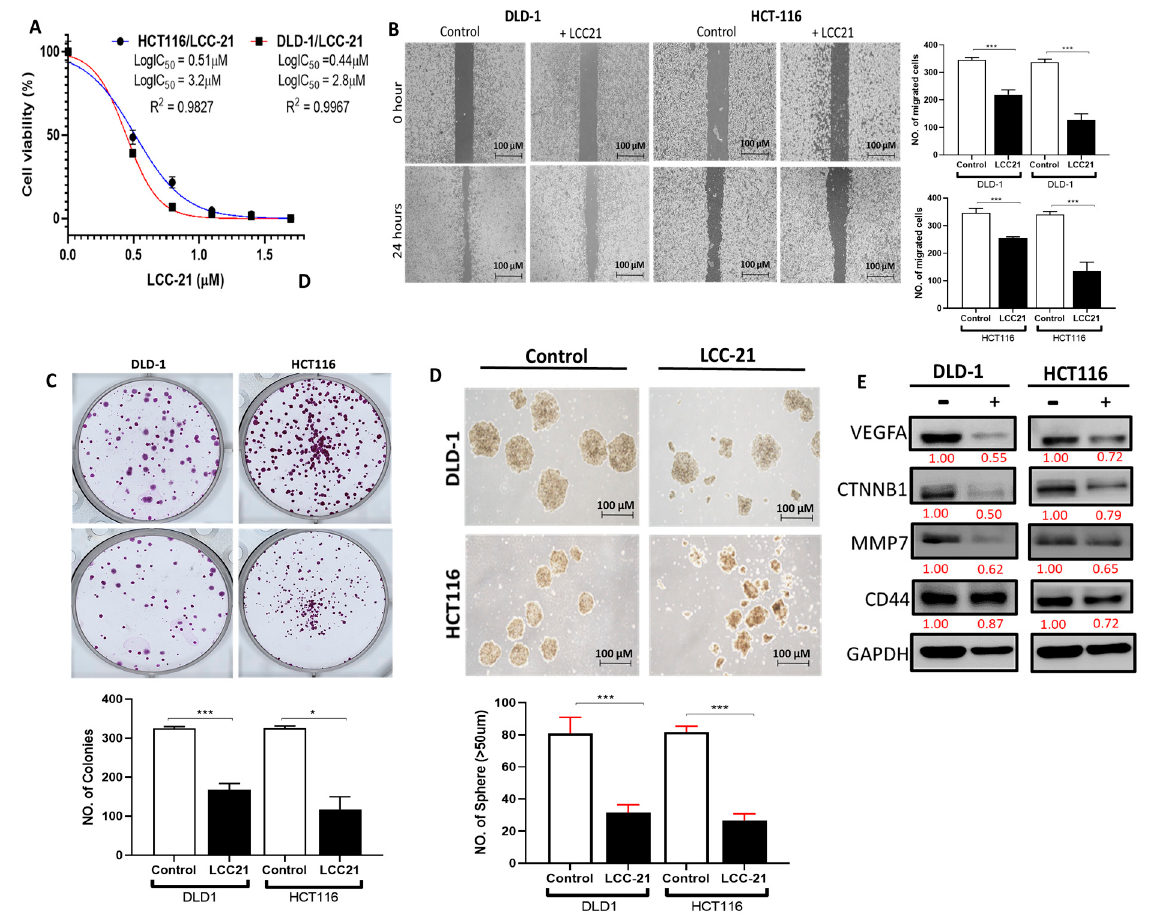
Figure 14. LCC ‐ 21 treatment suppressed the viability of colorectal cancer (CRC). ( A ) A cell viability assay demonstrated that LCC ‐ 21 effectively decreased the cell viability of CRC cell lines in dose ‐ dependent and time ‐ dependent manners. The experiments were performed three times, each with three replicates at each concentration The 50% inhibitory concentration (IC 50 ) values in the two cell lines (HCT116 and DLD ‐ 1) are indicated. ( B – D ) LCC ‐ 21 inhibited migration, colony, and sphere formation by DLD ‐ 1 and HCT116 cells. Images of the colony and spheroids are shown in the left upper panel, with quantification of the results in the right panel. ( E ) Western blot analysis shows that the LCC ‐ 21 significantly suppressed expression levels of vascular endothelial growth factor ‐α ( VEGFA )/beta catenin, ( CTNNB1 )/matrix metalloproteinase, ( MMP) ‐ 7 /cluster of differentiation 44 ( CD44 ), compared to the untreated group. GAPDH was used as an internal control. * p < 0.05, *** p < 0.01.